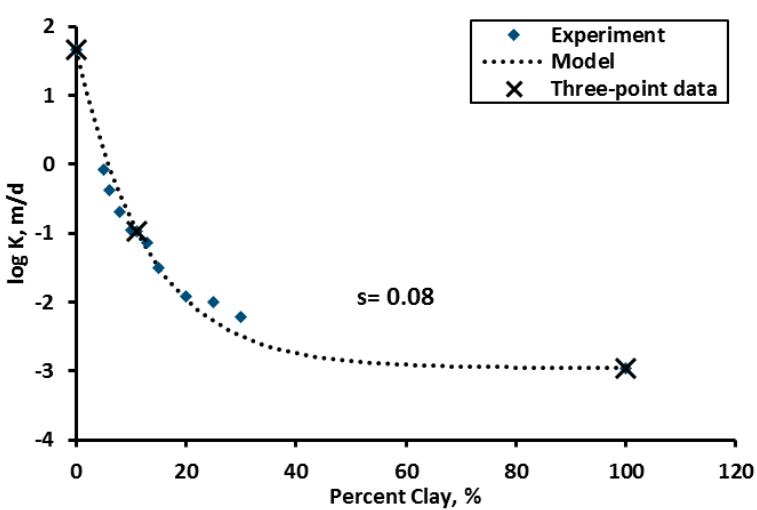
Figure 6. Comparison of fitted model results with experimental data for the natural clay and sand mixture. The cross symbol is used to identify the data points used in the three-point method discussed in Section 3.5.